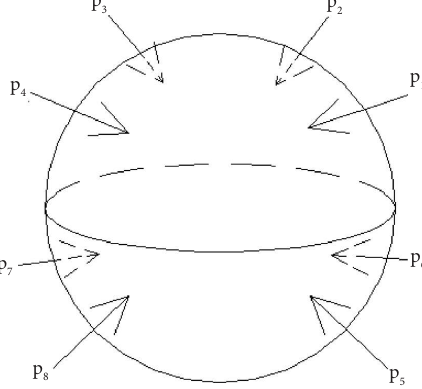
Figure 10: Forces acting on one particle.